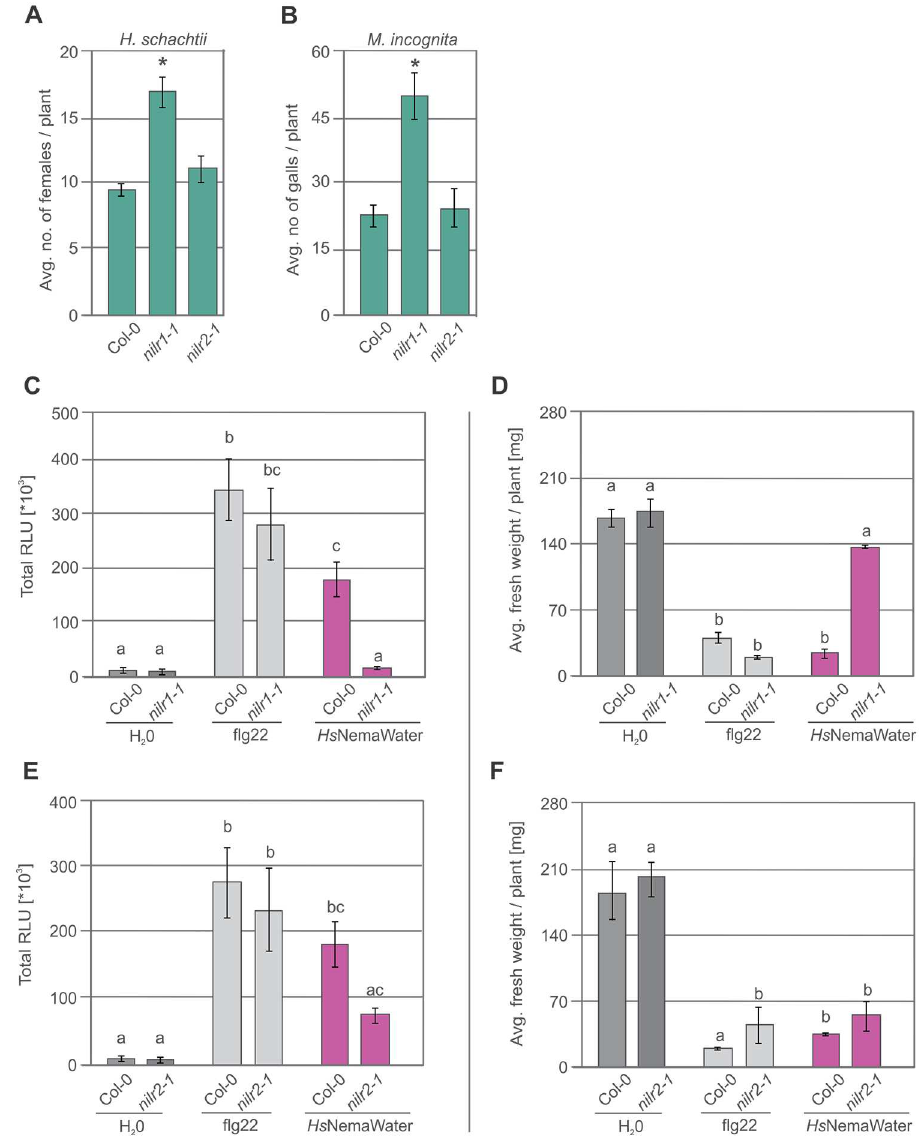
Fig 5. Knock-out nilr1-1 enhances susceptibility to nematodes. ( A ) Average number of female nematodes inducedby H . schachtii per plant in Col-0, nilr1-1 and nilr2-1 .Bars represent mean ± SE for three biological replicates. ( B ) Average number of galls induced by M . incognita per plants in Col-0, nilr1-1 and nilr2- 1 . Bars represent mean ± SE for three biologicalreplicates. ( C ) Root segments from Col-0, and nilr1-1 plants were treated with water, Hs NemaWater or flg22 and ROS burst was measured using L-012 based assay from 0 to 120 min. Bars represent mean ± SE for sixteen biological replicates. ( D ) 5-day-oldCol-0 and nilr1-1 seedlings were incubatedin water, Hs NemaWater, or flg22 for seven days. Fresh weight was measuredat 12 days after germination. Bars represent mean ± SE for three independent biologicalreplicates. ( E ) 5-day-old Col-0 and nilr2-1 seedlings were incubatedin water, Hs NemaWater, or flg22 for seven days. Fresh weight was measuredat 12 days after germination. Bars represent mean ± SE for three independent biological replicates. ( F) Root segments from Col-0 and nilr2-1 plants were treated with water, Hs NemaWater or flg22 and ROS burst was measuredusing L-012 basedassay from 0 to 120 min. Bars representmean ± SE for sixteen biological replicates ( A-E ) Data were analysedusing single-factor ANOVA and Tukey’s post hoc test (P < 0.05). Columns sharingsame letter are not statistically different.